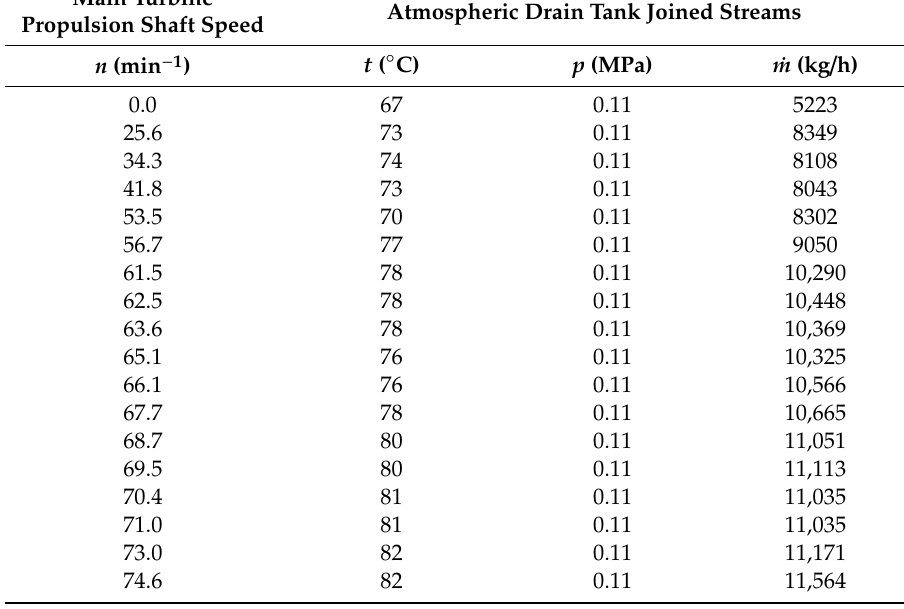
Table A3. Atmospheric drain tank joining